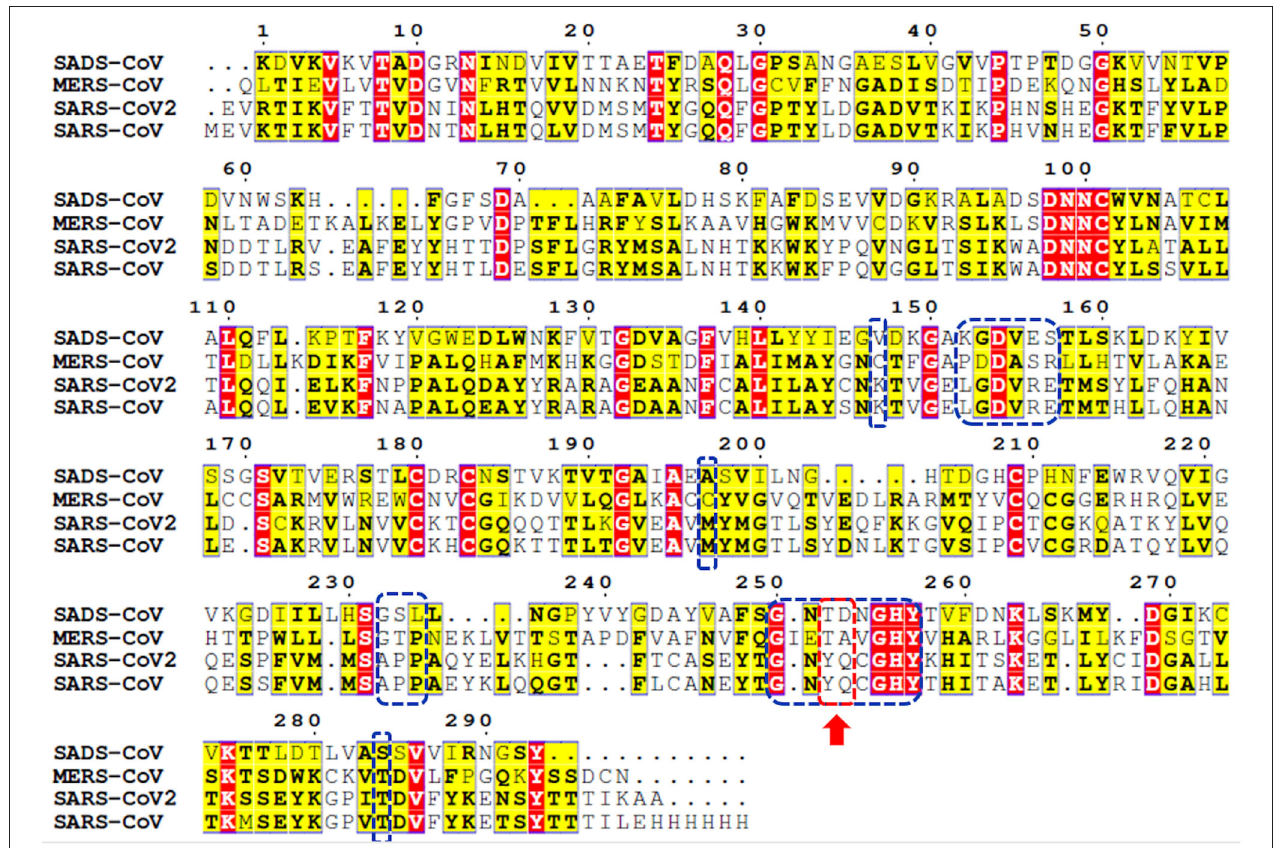
FIGURE 1 | Multiple-sequence alignment for PLpro sequences of some clinically relevant corona virus strains (SADS, MERS, SARS-CoV-2, and SARS-CoV). Identical and less conserved residues are highlighted red and yellow, respectively. Red arrow and red-dashed rectangle indicate the flexible loop residues Tyr269 and Gln270 as a part of the binding site. Residues of the binding site are marked by blue-dashed